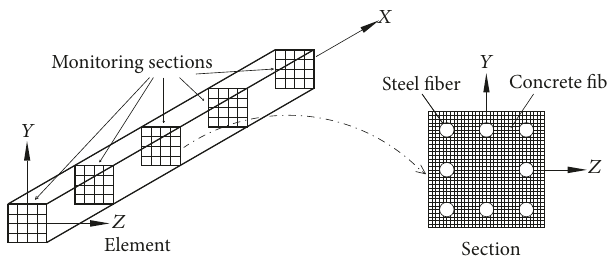
Figure 1: Modeling flexural members using fiber command.